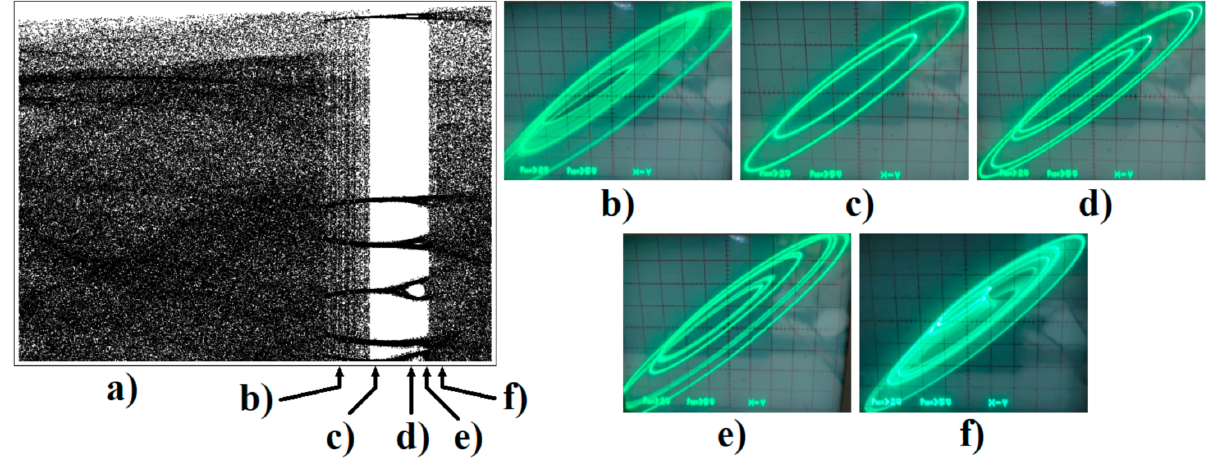
Figure 12. One-dimensional bifurcation diagram obtained by adjusting external voltage V b in circuit schematic: ( a ) focused range V b ∈ (4.8, 5) V. Plane projection of generated state attractors for values: ( b ) V b = 4.88 V, ( c ) V b = 4.92 V, ( d ) V b = 4.96 V, ( e ) V b = 4.98 V, and ( f ) V b = 5